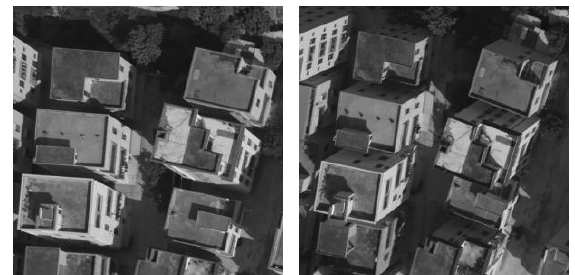
Figure 6. Dataset1: low-altitude UAV images. Image size is 1024×1024 pixels. Image resolution is 0.05m.